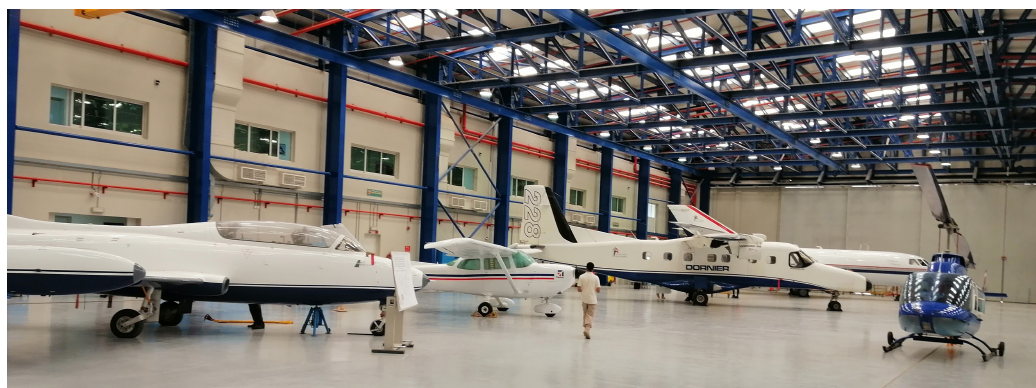
Figure 5. Abu Dhabi Polytechnic Aircraft Hangar.